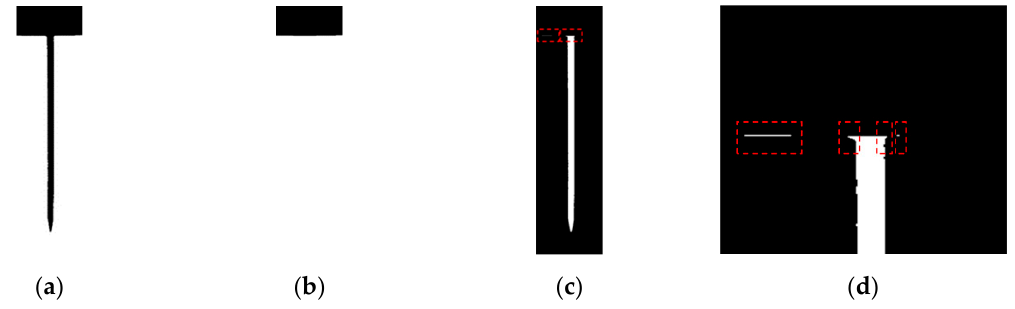
Figure 7. Cutting blade detection using the morphological filter. ( a ) Binary image; ( b ) background region modeling; ( c ) background removed image; ( d ) enlarged view of the image with fine noise.